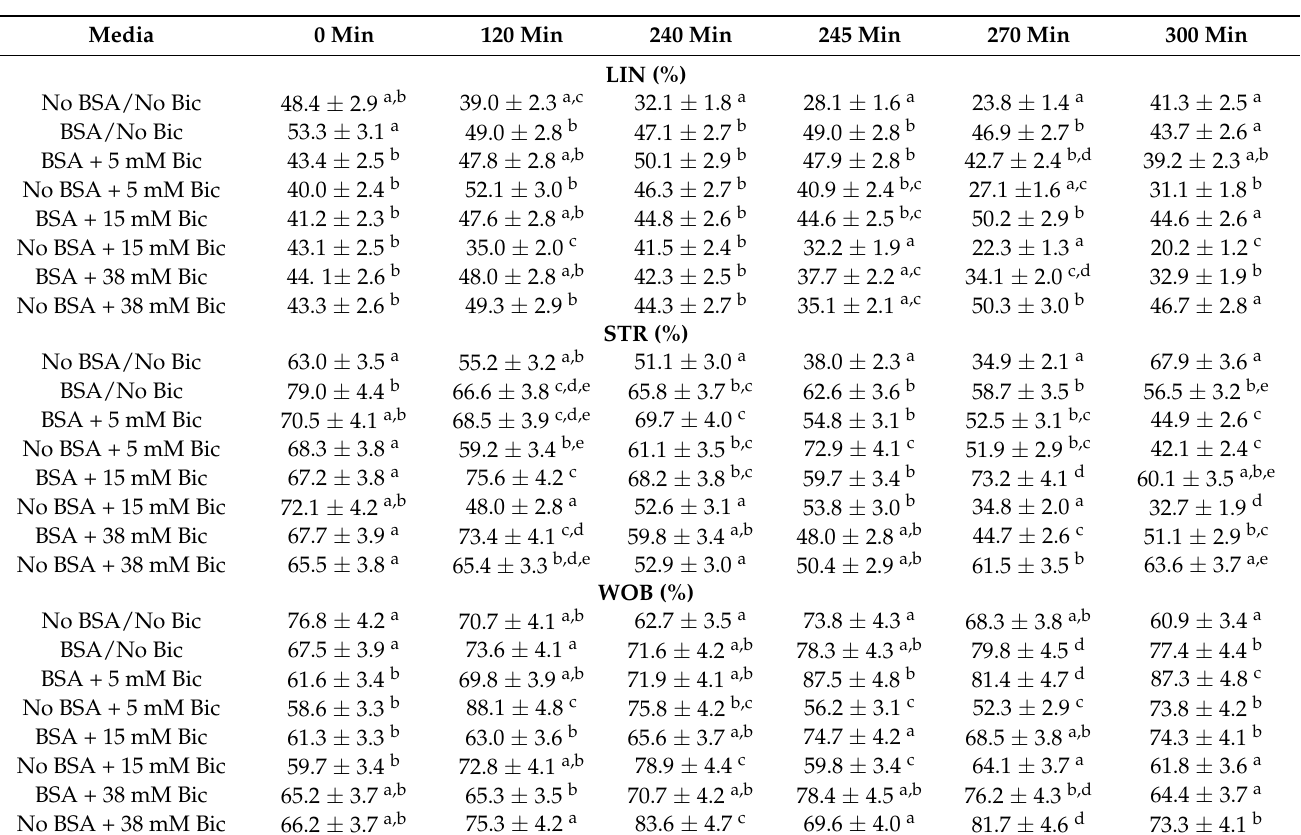
Table 2. Percentages of linearity (LIN), straightness (STR) and oscillation (WOB) following incubation of pig sperm with different concentrations of bicarbonate (Bic; 0 mM, 5 mM, 15 mM, 38 mM) and BSA (0, 5 mg/mL) for 300 min. Progesterone (10 µ g/mL) was added at 240 min to induce acrosome exocytosis. Different superscripts (a–e) indicate significant differences ( p < 0.05) between treatments (rows) within the same time point. Data are shown as mean ± SEM for 12 independent